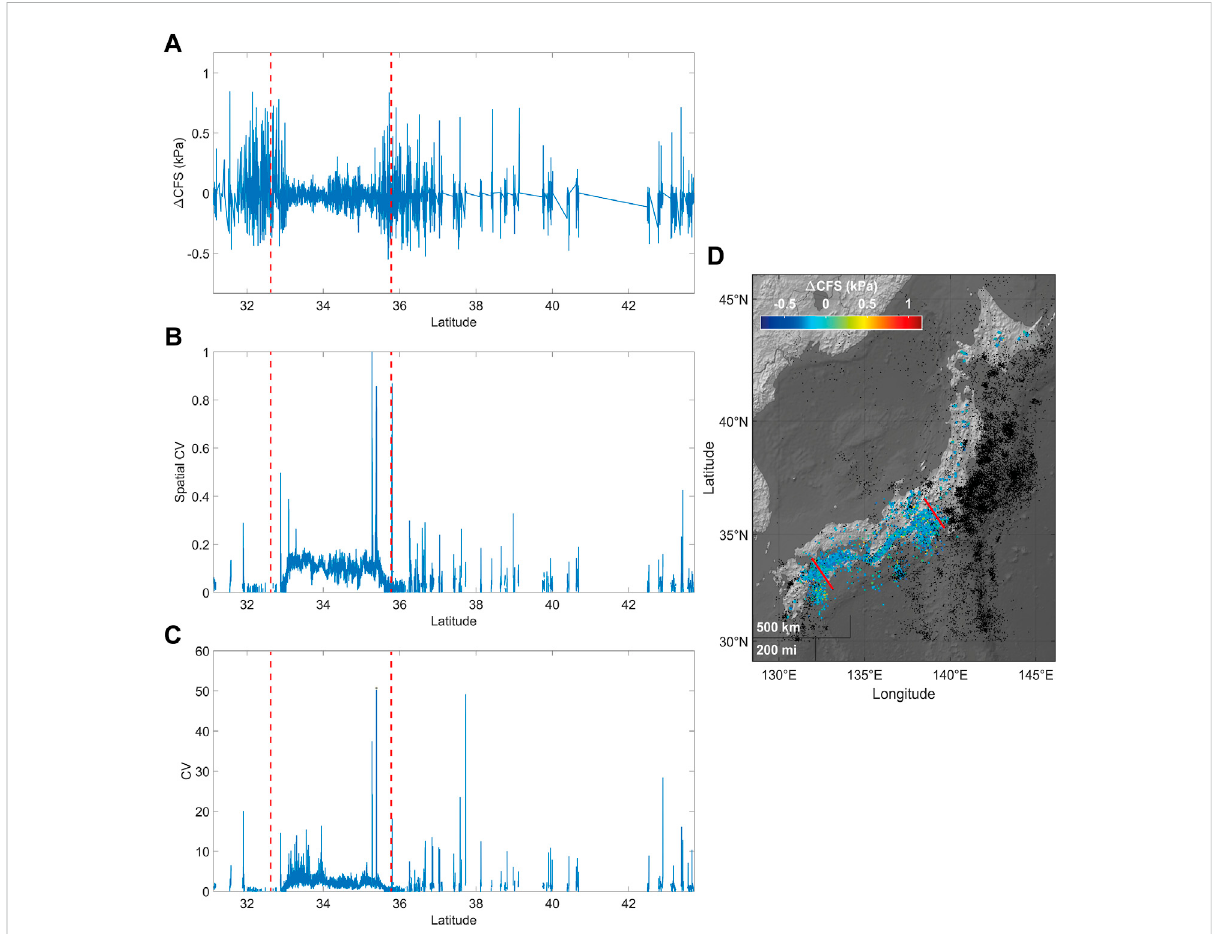
FIGURE 5 (A) Δ CFS for tremors along the Nankai Trough as a function of epicentral latitude. We highlight two segments hosting tremors with signi fi cant responsivenesstotidesapproximatelylocatedat33 ° and36 ° N(redlinesinthemapanddashedredlinesinpanelsa,b,andc). (B) Spatialcoef fi cientof variationfortremorsalongtheETSzone. (C) Coef fi cientofvariationoftremortimeseriesbetween2005and2018asafunctionoflatitude[datafrom Ideharaetal. (2014);Supinoetal. (2020)].Twominima areobservedincorrespondencewith themaximaof theaverage Δ CFS plotted in (A) and the minima points of the spatial coef fi cient of variation. (D) Map of tremors in Nankai and LFEs in 52 volcanic areas in Japan. Kurihara and Obara (2021). Black points represent regular earthquakes (USGS catalog, 2005 – 2021, M L ≥ 4.0), and their size is proportional to the